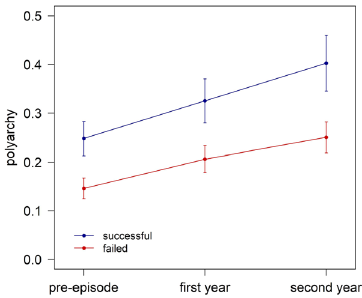
Fig. 1 Initial condition of the Electoral Democracy Index for successful and failed liberalization episodes. Successful (blue) and failed (red) episodes signi fi cantly differed in their Electoral Democracy Index (EDI) in the year the episode began, as well as the years just before and after (99.9 percent con fi dence intervals).